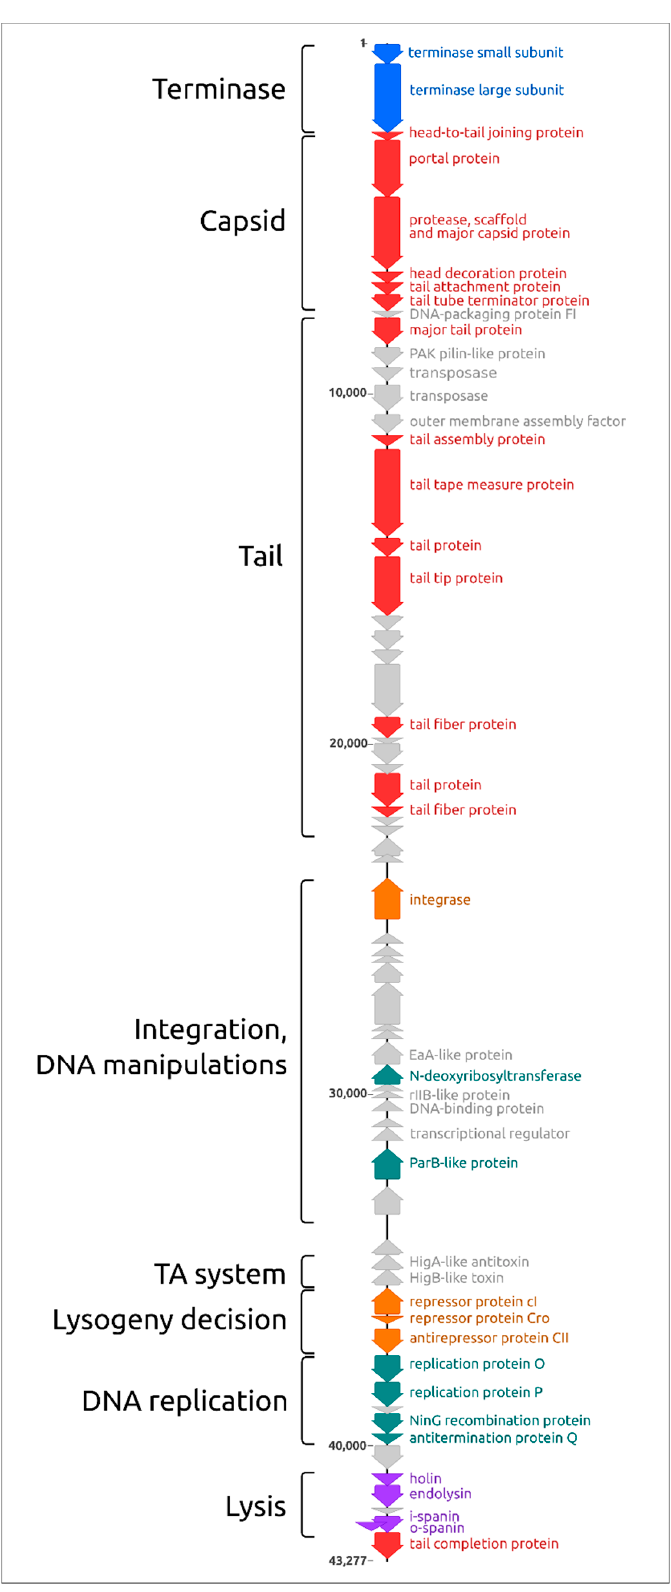
Figure 3. Genetic map of Pseudomonas phage MD8 and approximate location of functional modules (left). The colours of genes are as follows: blue, terminase; red, virion; orange, lifestyle; green, DNA manipulations and replication; purple, lysis. The remaining proteins, including the hypothetical ones, are coloured grey.